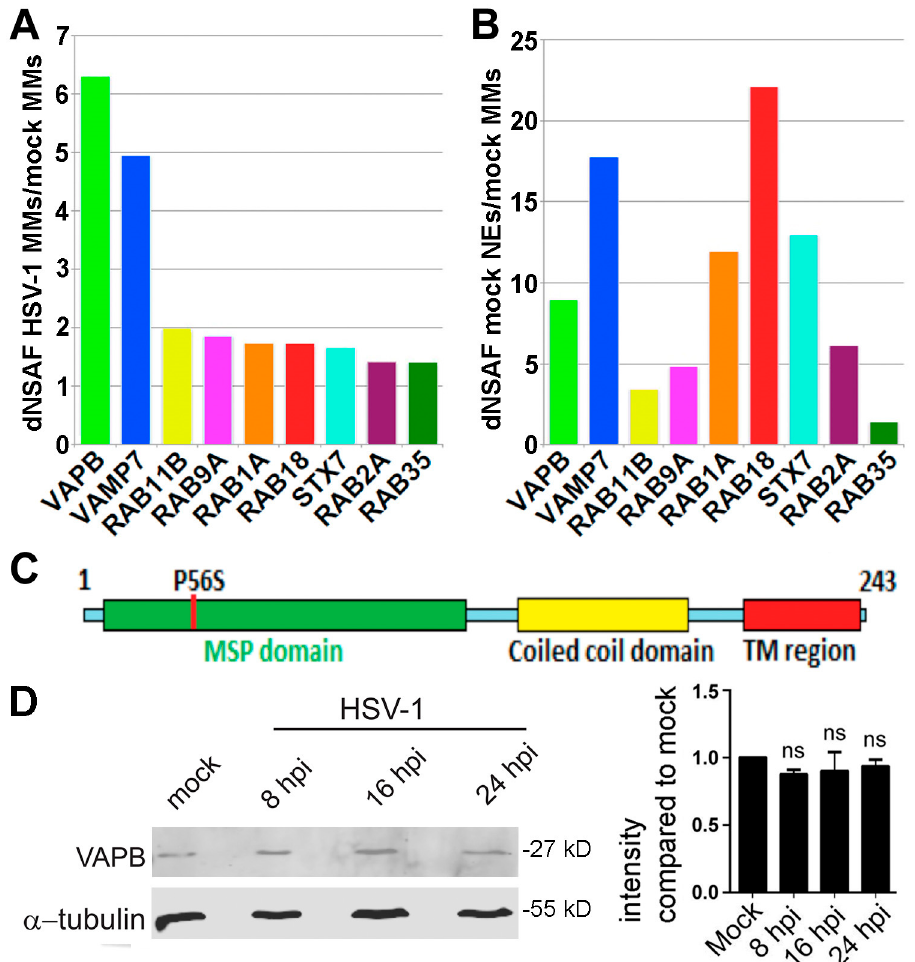
Figure 2. Enrichment of VFPs in HSV-1 infected MMs identified by mass spectrometry. ( A , B ) Protein abundance estimates based on spectral counts and protein length as a percentage of the total number of spectra identified per mass spectrometry run (dNSAF, see Methods) were used to calculate relative enrichment between the three mass spectrometry datasets. The ratio of dNSAF values for different VFPs between HSV-1 infected MMs and mock-infected MMs ( A ) and between NEs and mock-infected MMs ( B ) are shown. Only those VFPs that had a HSV-1 infected MMs:mock-infected MMs ratio of >1.3 are presented. ( C ) Domain structure of VAPB. The protein has an MSP domain that when mutated at P56S causes a variant of amyotrophic lateral sclerosis (ALS8), followed by a coiled-coil domain that precedes the C-terminal transmembrane domain. ( D ) Lysates from HSV-1 infected or mock-infected HeLa cells were analyzed by Western blot for VAPB at different times post-infection. Quantification on repeats for 3 time-points by Li-COR shown on the right revealed no change in VAPB levels during the course of infection.